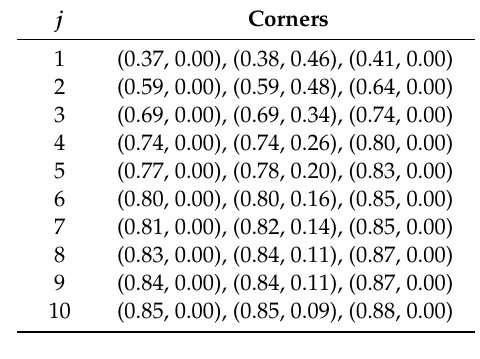
Table 4. Fuzzy intersection results for the Chen and Lin method.